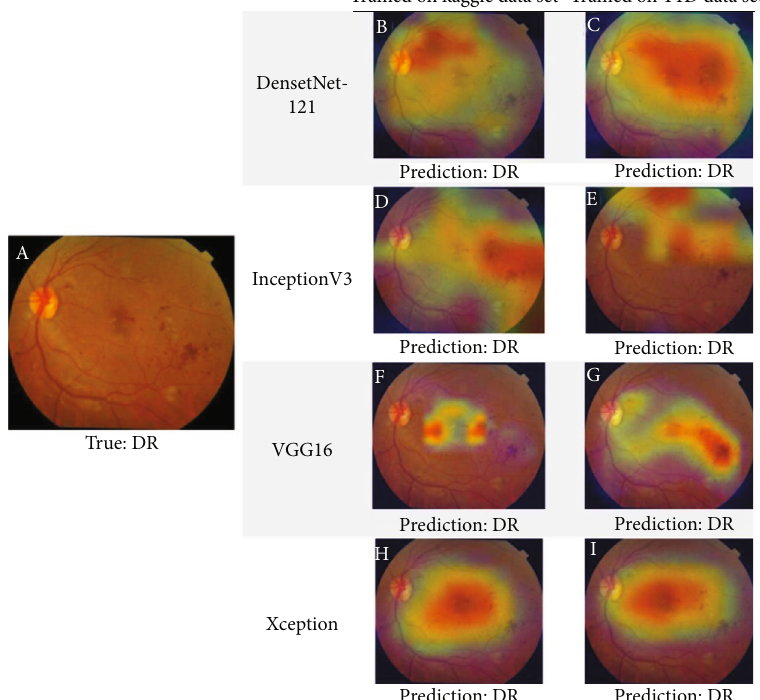
Figure 4: The images demonstrate the original (a) and superimposed Grad-CAM activation maps ((b) – (i)) of the selected diabetic retinopathy (DR) color fundus image. All models gave a true-positive prediction. There were some similarities in activation maps even in di ff erent transfer learning models trained with di ff erent